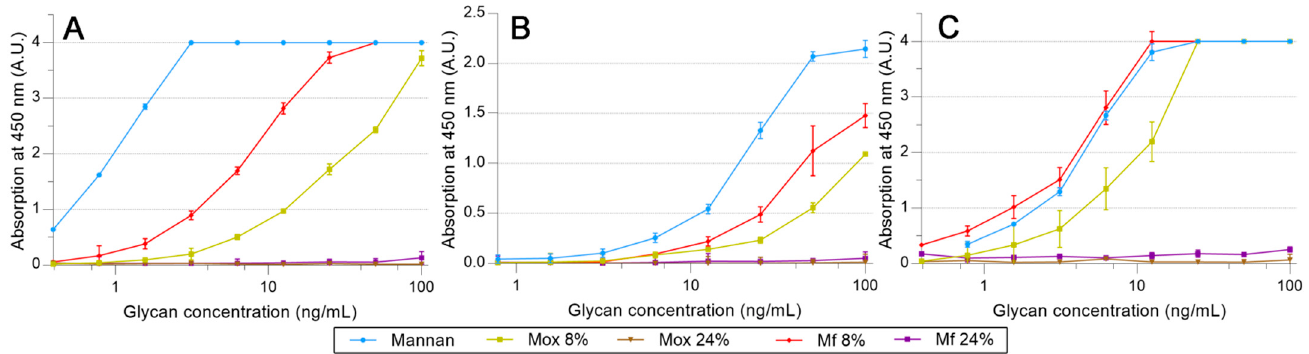
Figure 8. Avidity determination between fluorescent mannan and fixed hMBL ( A ), hSP-D ( B ), and pSP-D ( C ) obtained using the protocol described previously.